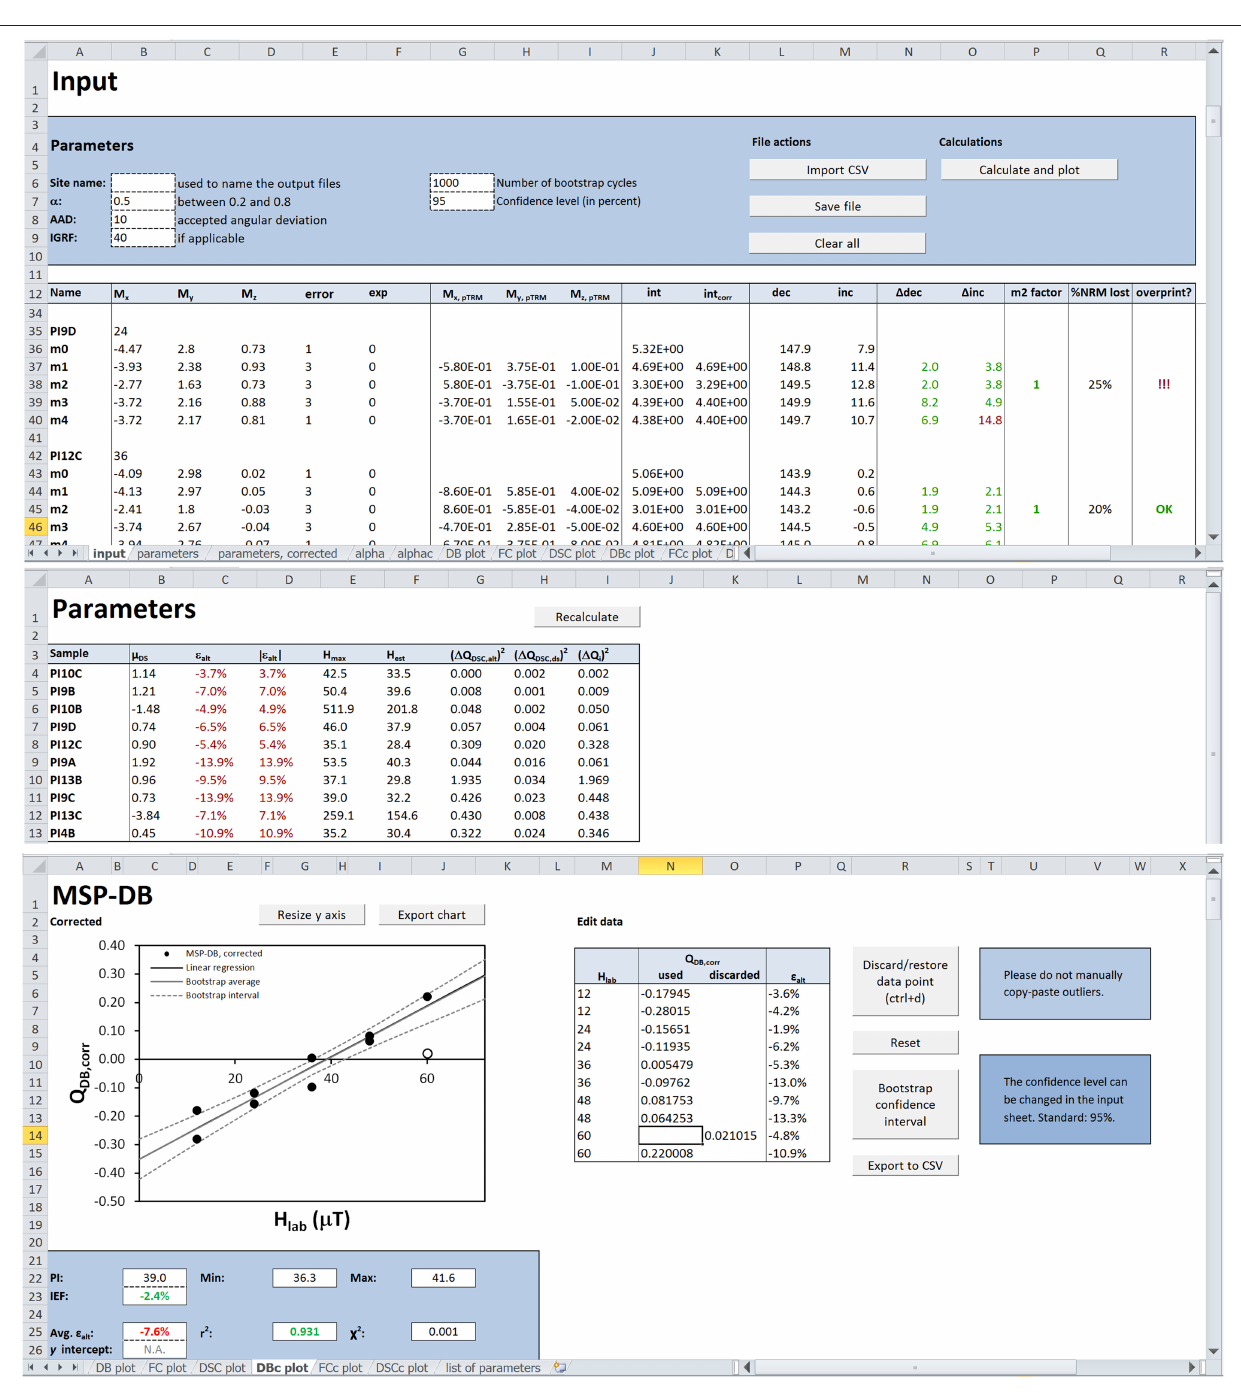
Frontiers in Earth Science |